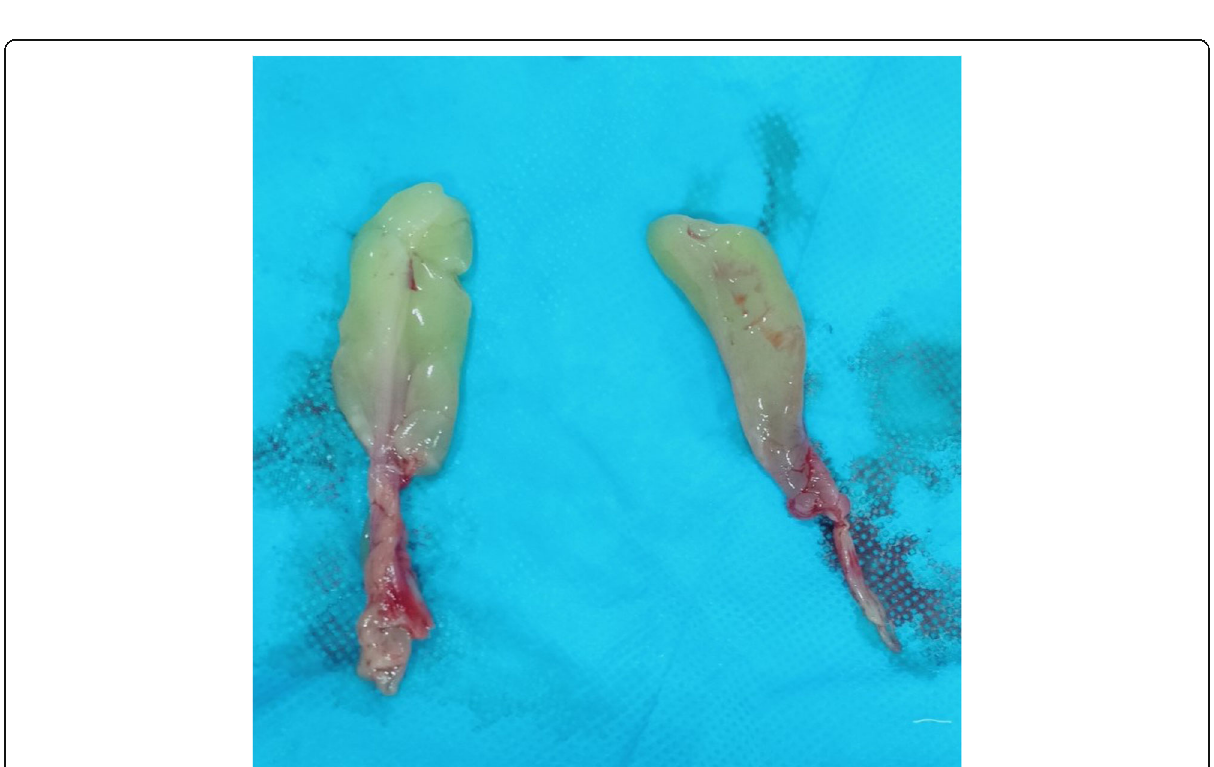
Fig. 3 Macroscopic aspect of bilateral Killian